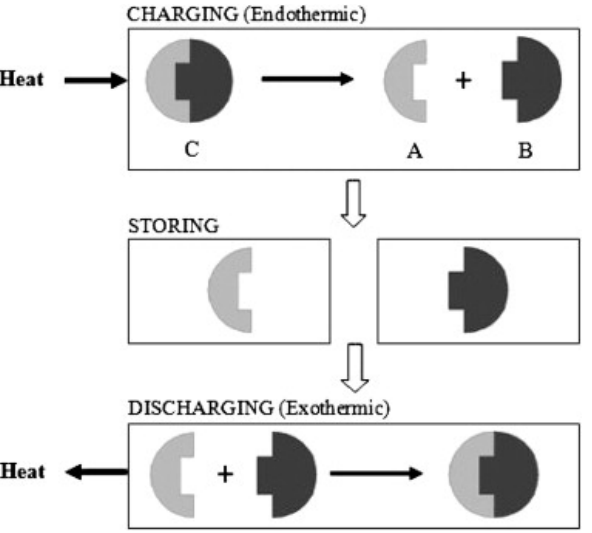
Figure 1. Processes in TCES cycle: charging, storing and discharging [11].